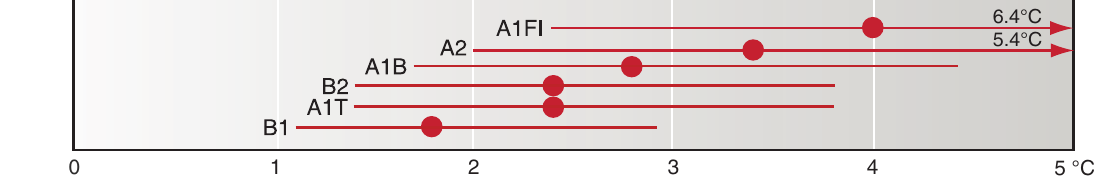
Warming by 2090-2099 relative to 1980-1999 for non-mitigation